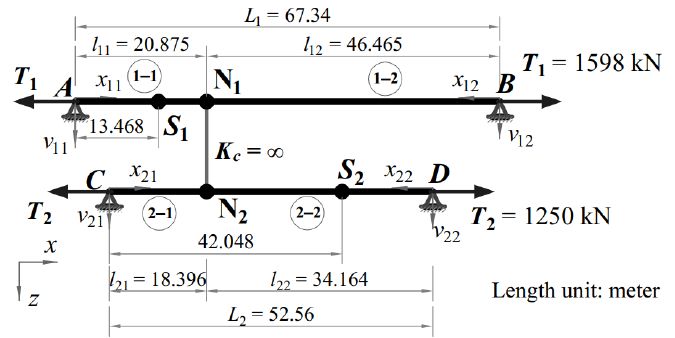
Figure 1. An example of cable network configuration.